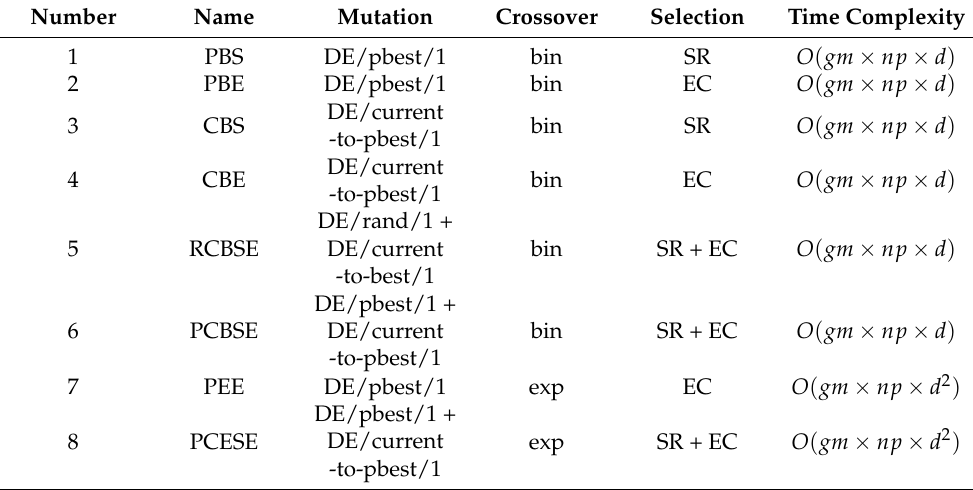
Table 4. The design of the algorithms.